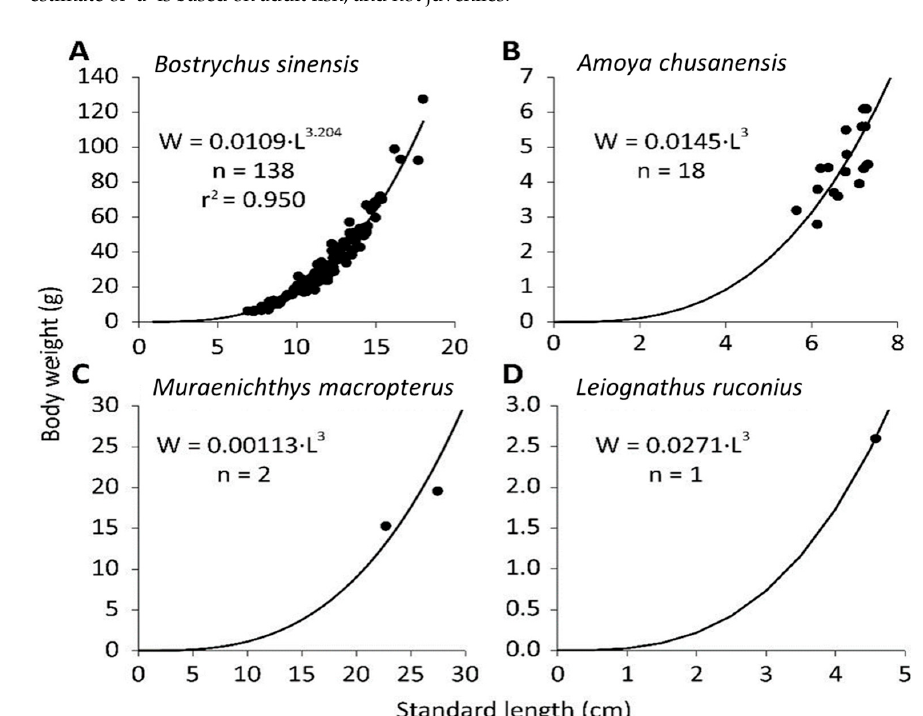
Figure 2. Example of different types of length–weight relationships (LRW) derived for mangrove fishes from Dongzhaigang Bay, China from July 2020 to April 2021. ( A ): a common LWR, covering a wide range of size with numerous L–W data pairs, and whose parameters (a, b) were estimated by a linear regression of log(W) vs. log(L); see also Table 1. ( B ): an LWR with b set at an assumed value of 3 because the L–W data pairs cover only a narrow range of sizes. ( C ): the same, with only 2 L–W data pairs. ( D ): the same with only 1 L–W data pair. See Table 2 for more cases similar to ( B – D ), and the text for comments on the assumption that b = 3.